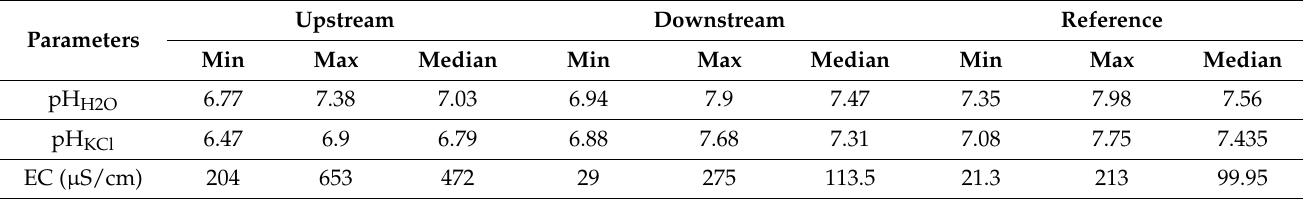
Table 7. Basic statistical results of pH and EC analyzes in the sediment near the hydroelectric power plant on the Ślęza River.